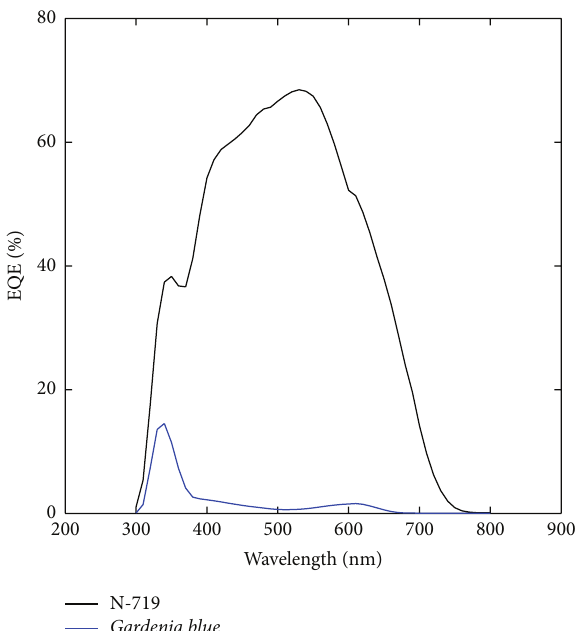
Figure 9: IPCE values of Gardenia blue and